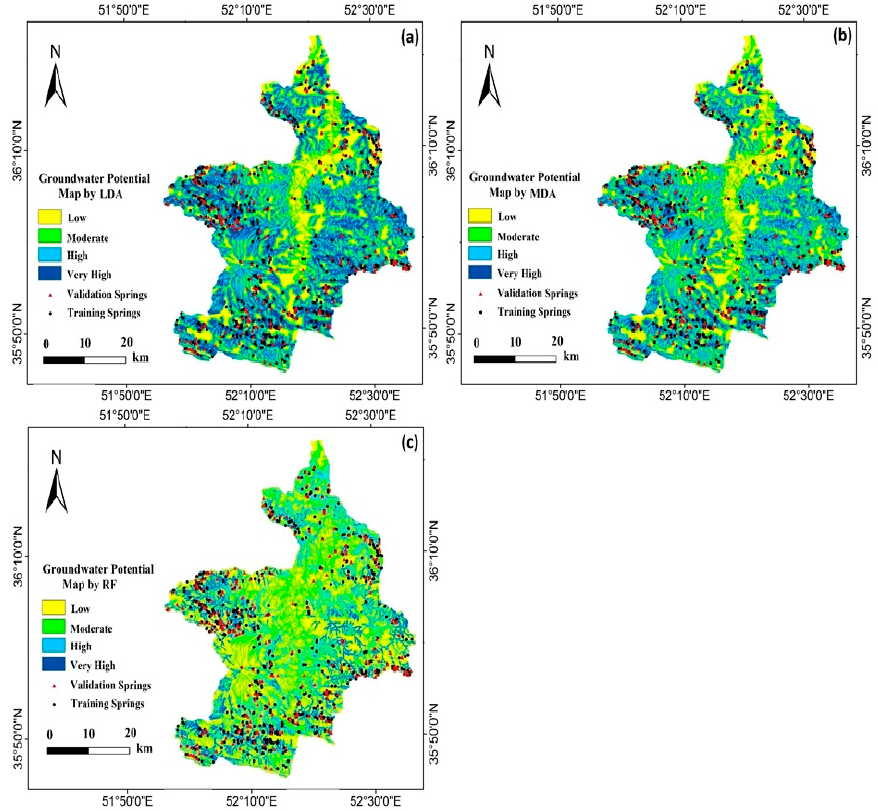
Figure 5. Groundwater potential map produced by ( a ) LDA, ( b ) MDA, and ( c ) RF models.